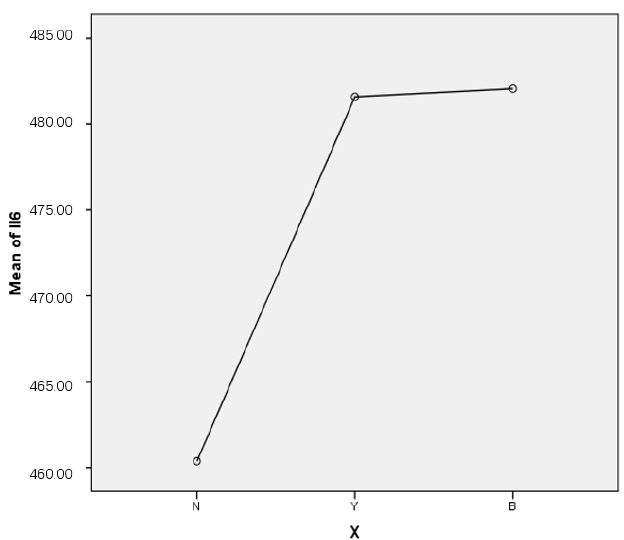
Figure 4. Sample of Mean